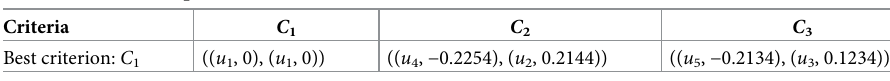
Table 3. Pairwise comparison vector for the best criterion. Criteria